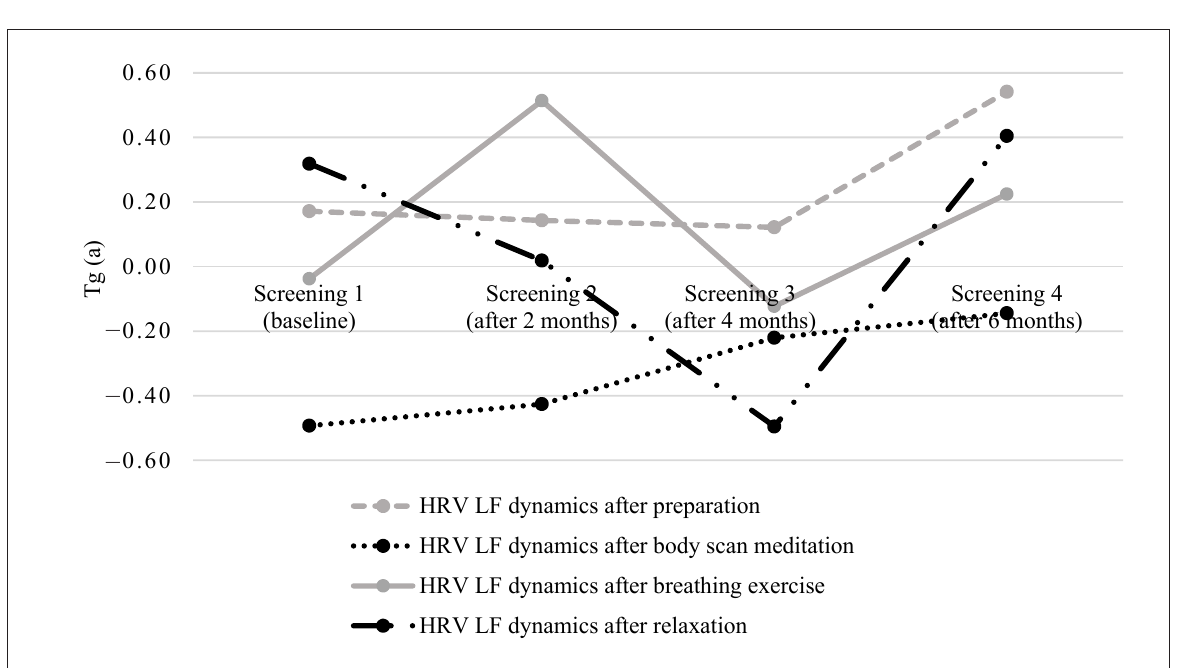
Figure 3. HRV vLF dynamics during 6-month